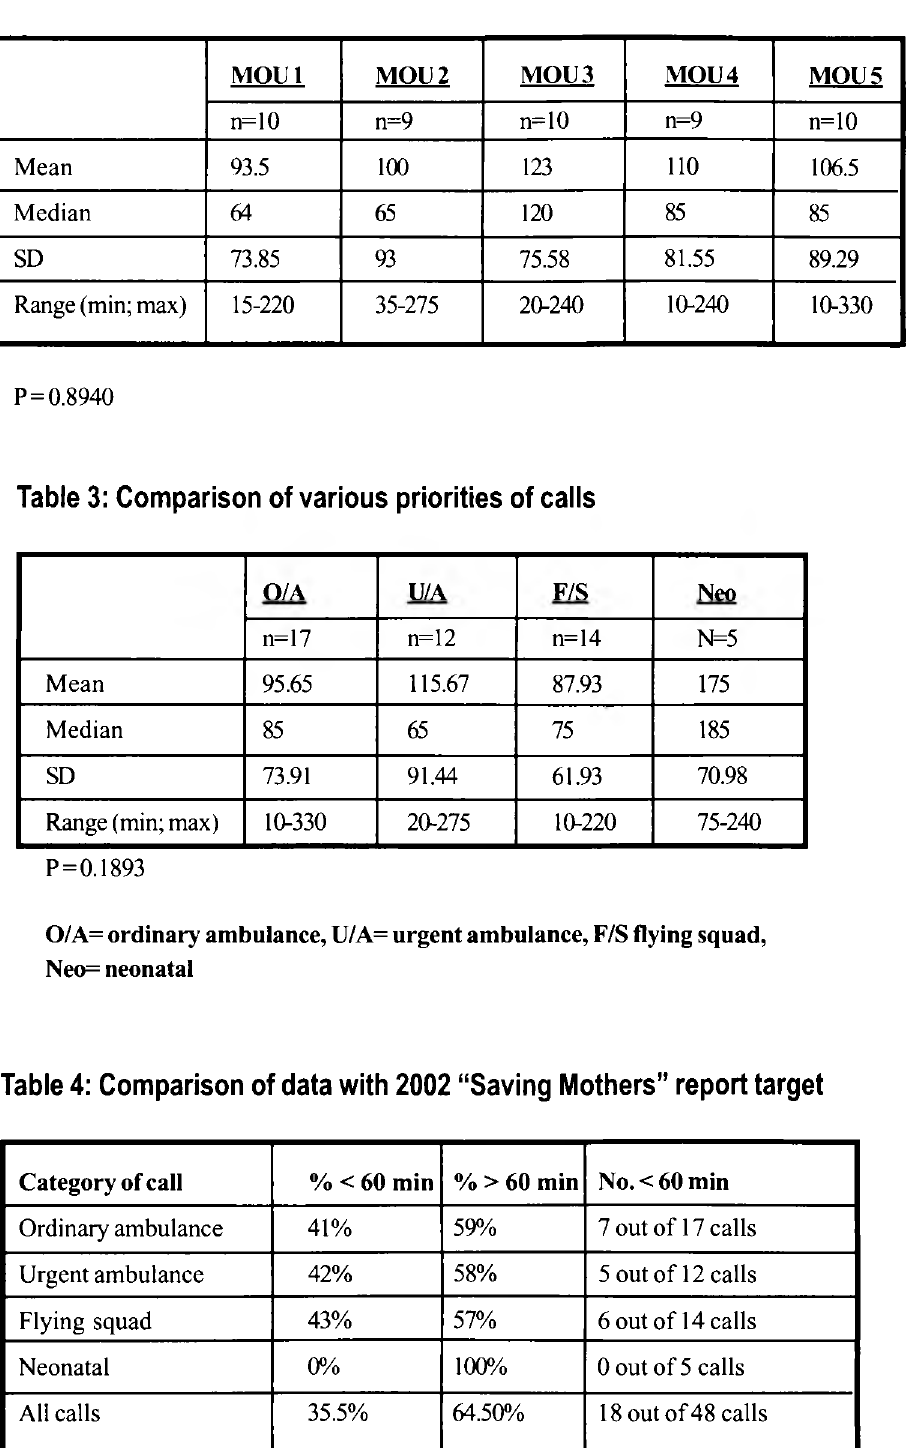
Table 2: Comparison of response times in minutes between units